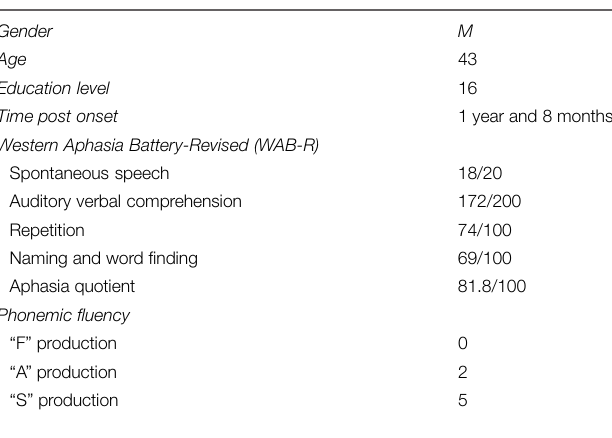
TABLE 1 | Sociodemographic and clinical